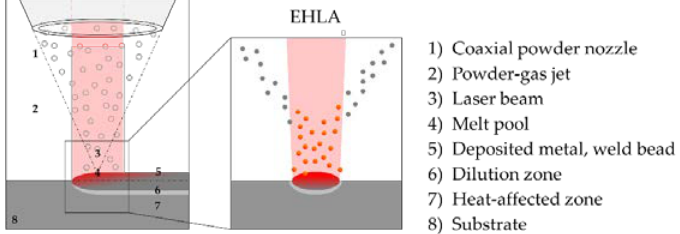
Figure 3. Diagram of the principle behind the extreme high-speed laser material deposition (EHLA) process [1]. Reprinted with permission from Ref [1]. Copyright 2020, Fraunhofer Verlag.